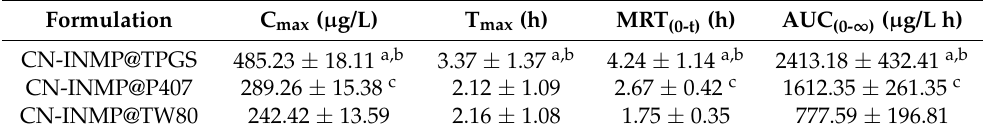
Table 2. The main pharmacokinetic parameters of the tested CN-INMPs after pulmonary administra- tion at a dose of 20 mg/kg (x ± s, n =